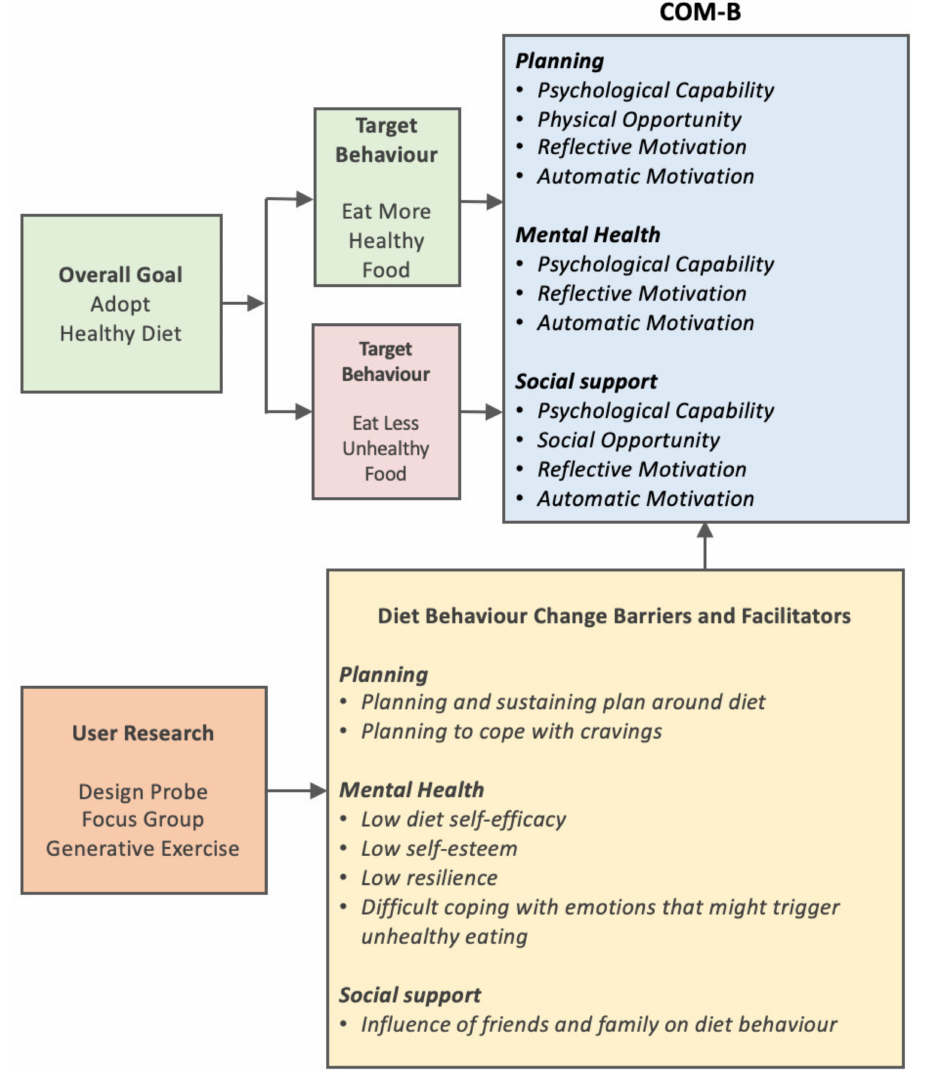
Figure 8. Selecting and specifying the targeted behaviours using the COM-B